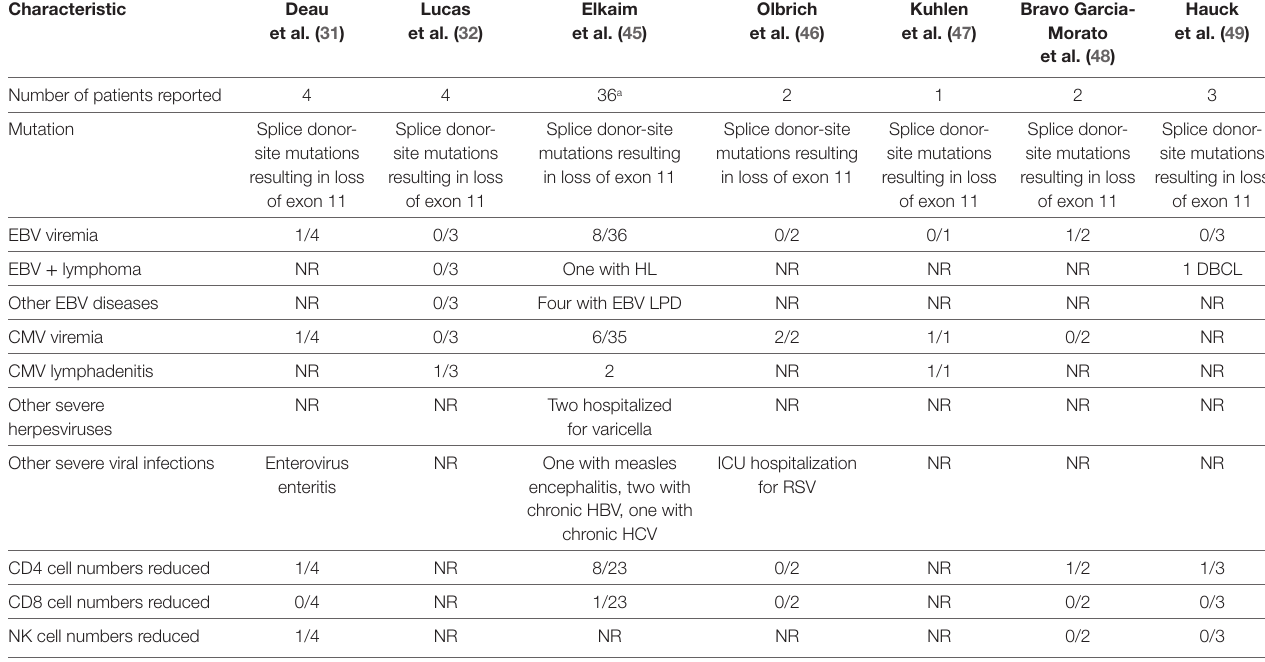
TABLe 2 | Viral infections in patients with germline gain-of-function mutations in PIK3R1.